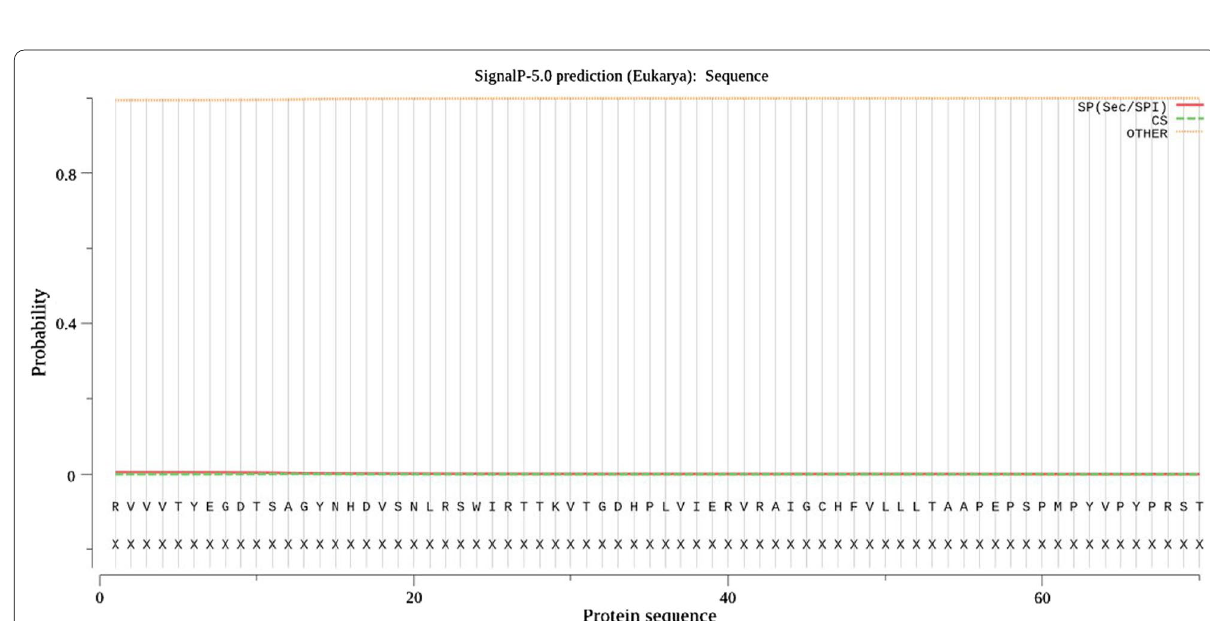
Fig. 9 The signal peptide likelihood was absent in the HEV Y-domain. The analysis was conducted using SignalP-5.0 prediction